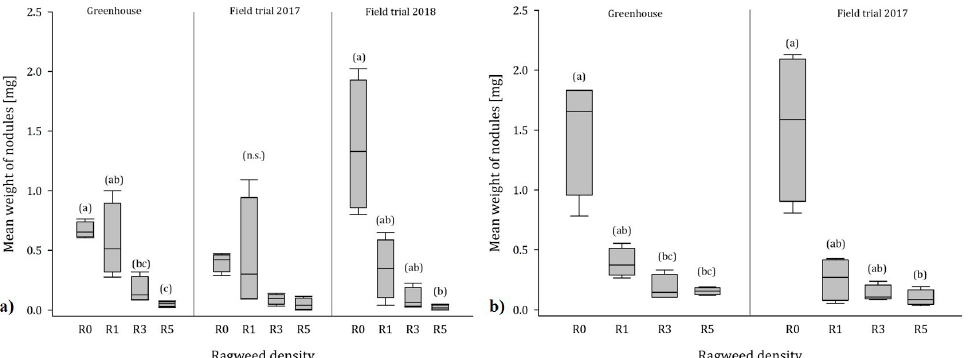
Figure 4. Mean weight of nodules [mg dry matter] dependent on ragweed density (0, 1, 3, and 5 plants: R0, R1, R3, and R5) of ( a ) cultivar Albenga and ( b ) cultivar ES Mentor, separated by trial (n = 4; different letters indicate significant differences).